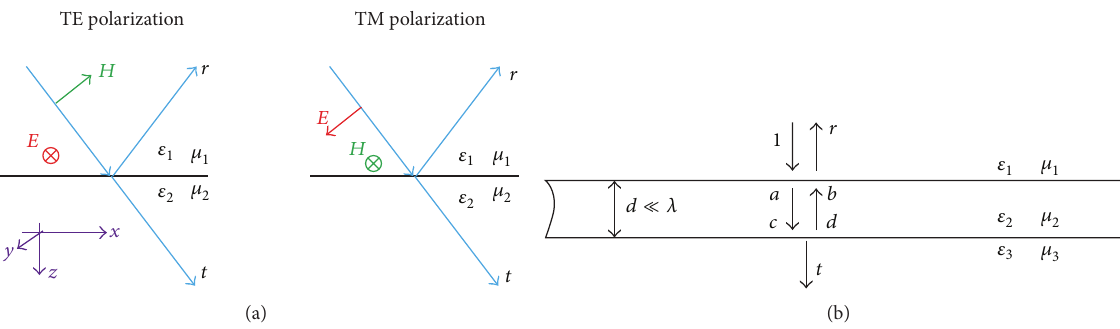
Figure 3: Boundary conditions at the interface between (a) two media and (b) a slab embedded in the two half spaces. Figures are reproduced from